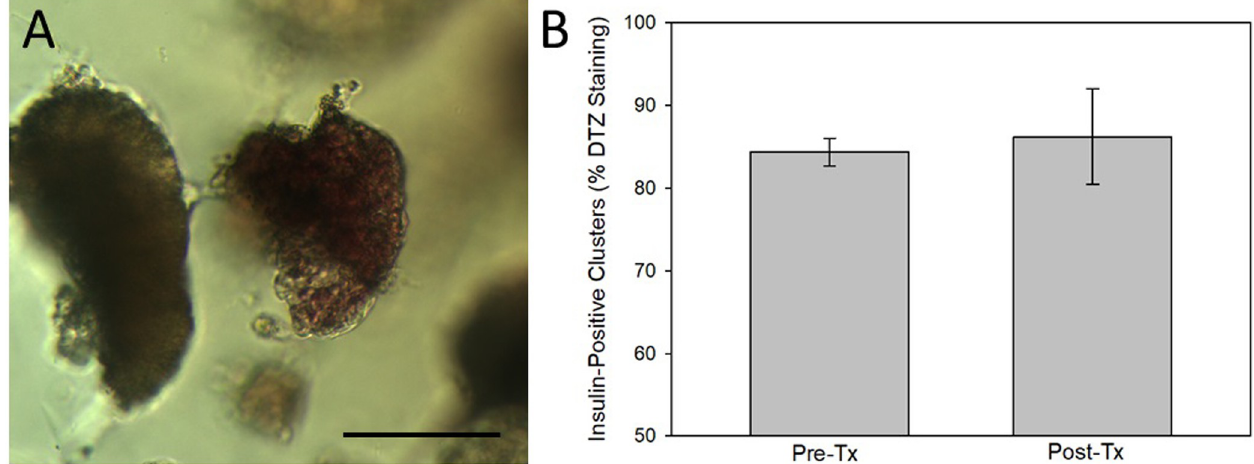
Fig 9. Dithizone staining of explanted microspheres. A) Example of a positively stained islet for insulin (via dithizone). Scale bar = 20 μ m. B) The percentage of insulin-positive clusters (dithizone stained) were compared prior to transplantation and after. There were no differences between the groups.